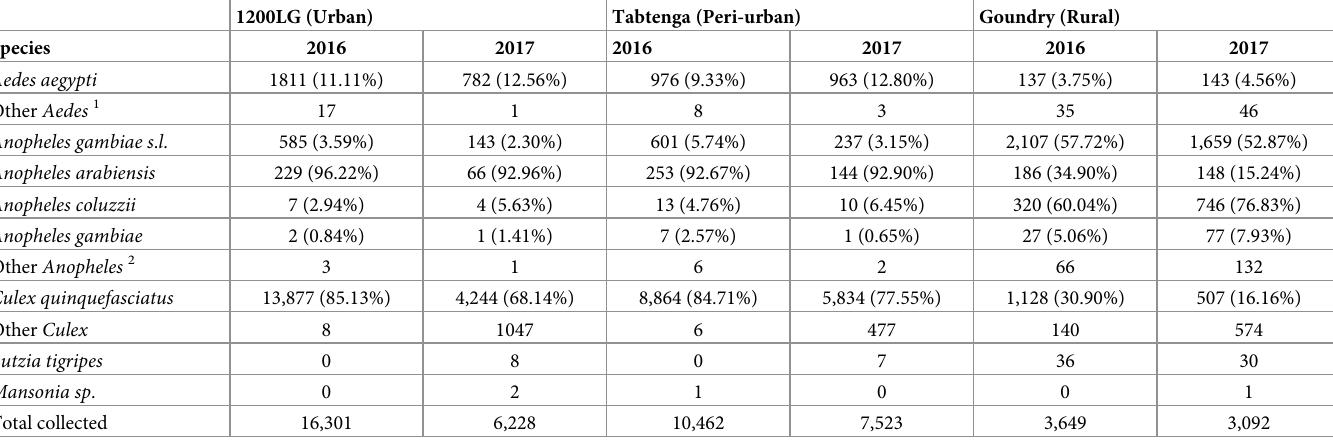
Table 1. Species, number and proportion of adult mosquitoes collected indoors and outdoors in three localities of Ouagadougou in 2016 and 2017. Proportions were calculated only for the most common vector species Aedes aegypti , Anopheles gambiae , Culex quinquefasciatus